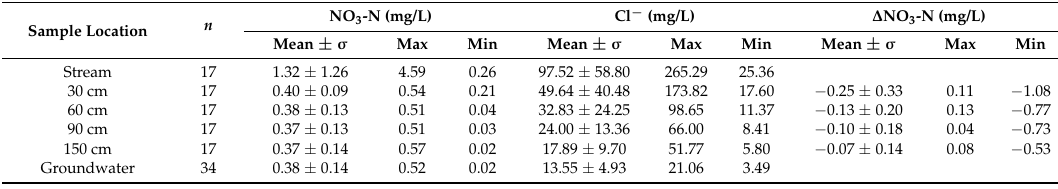
Table 1. Descriptive statistics of the seasonal nitrate as nitrogen and chloride concentration data for the water samples.